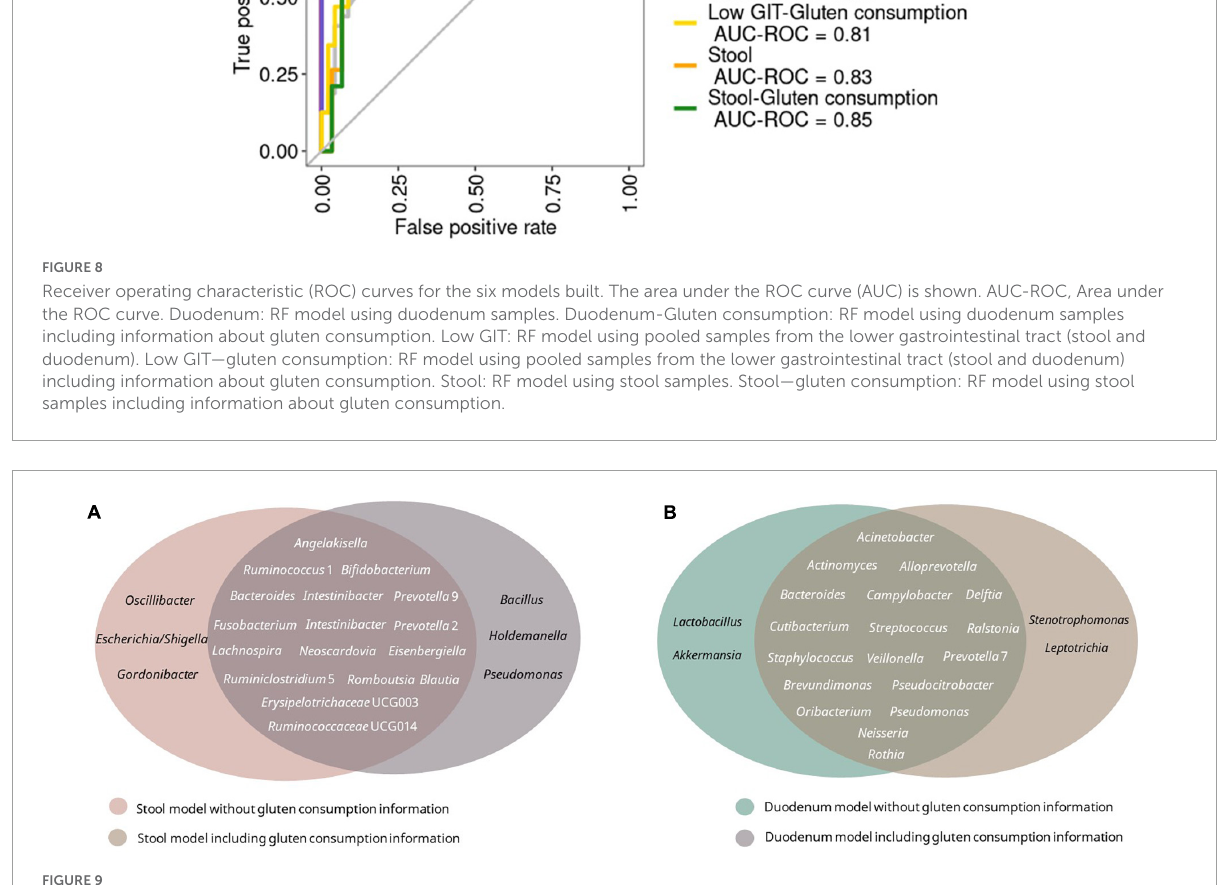
FIGURE9 Top 20 best-ranked microbial features of each model. (A) Stool model with/without gluten consumption; (B) duodenum model with/without gluten